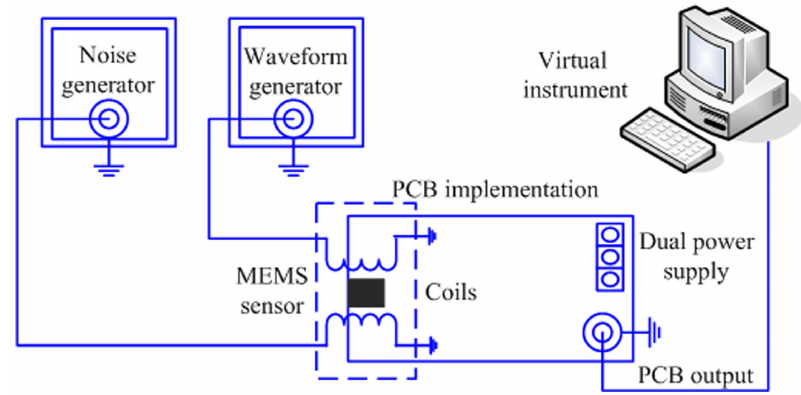
Figure 4. Experimental setup for the detection of magnetic signals by a MEMS sensor using stochastic resonance.